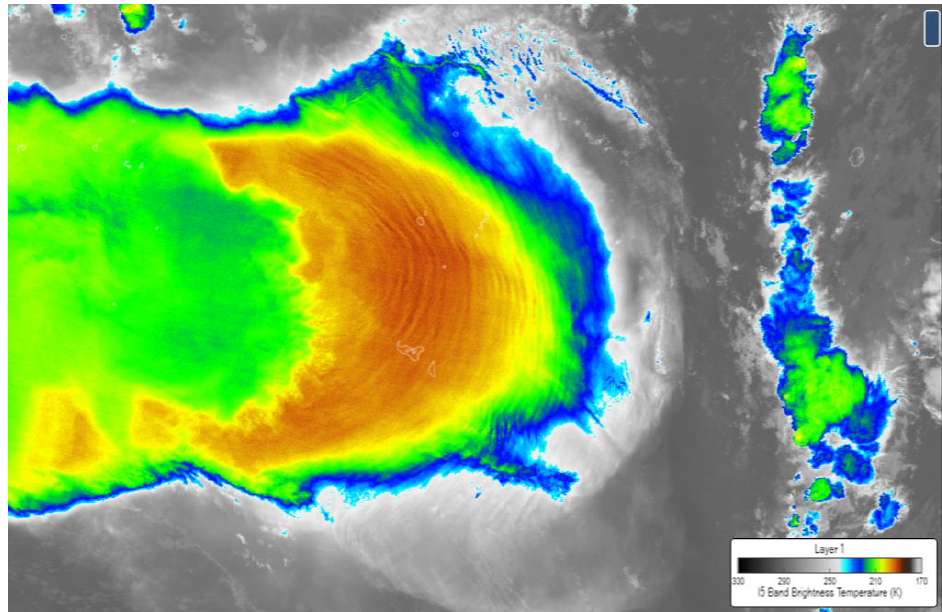
Figure 7. Native resolution image of the S-NPP VIIRS I-5 band nighttime observations after the Tonga Volcanic eruption, showing the clear tropospheric gravity wave features at the fine resolution of 375 m.